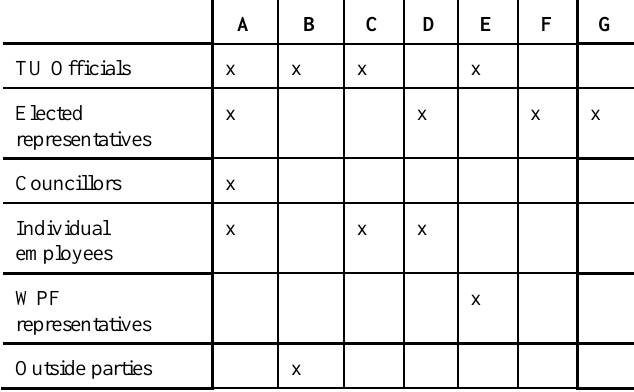
Table 3: TU/worker representatives’